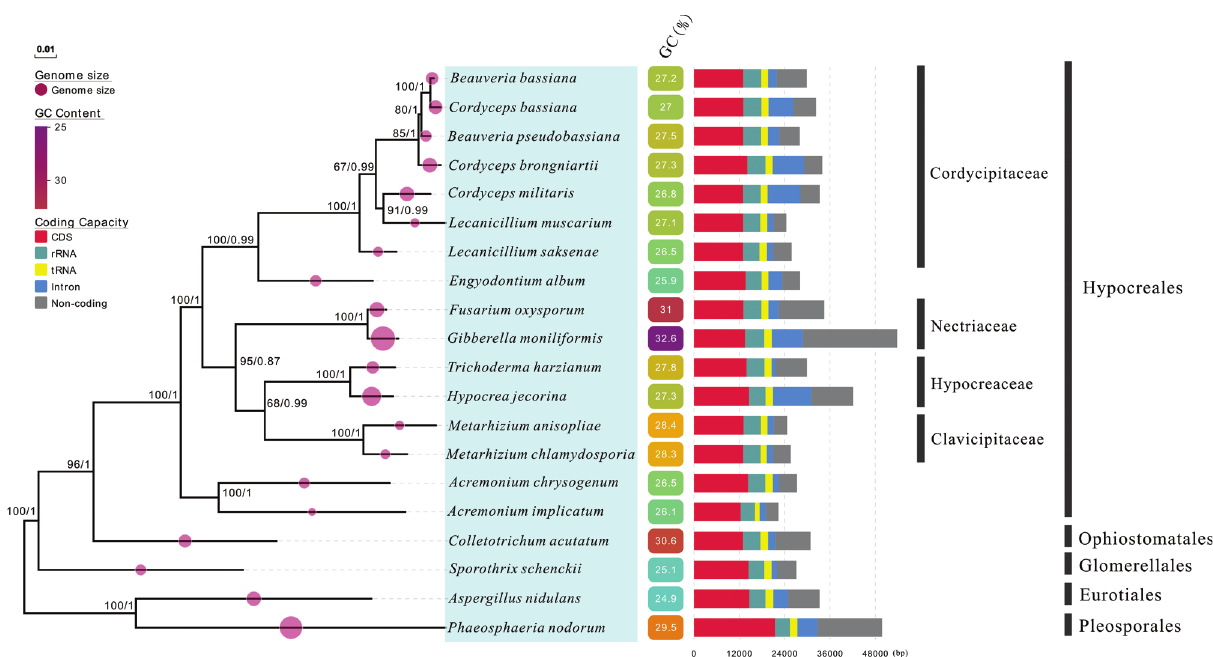
Figure 3 - Genome-similarity comparison ring constructed using BRIG